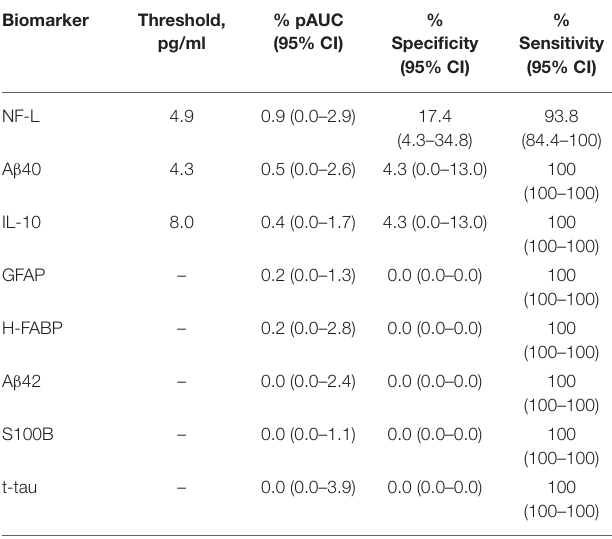
TABLE 7 | Individual abilities of the eight different biomarkers in discriminating patients with complete and incomplete recovery without head imaging abnormalities sorted by partial area under the curve of the receiver operating characteristic (all, n = 55; complete recovery, n = 32; incomplete recovery, n =